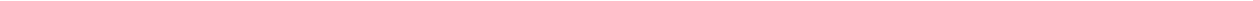
Fig. 7 Syt11 knockdown rescues parkin knockdown-induced de fi cits in DA release and motor behavior. a Schematic of unilateral parkin knockdown (KD)